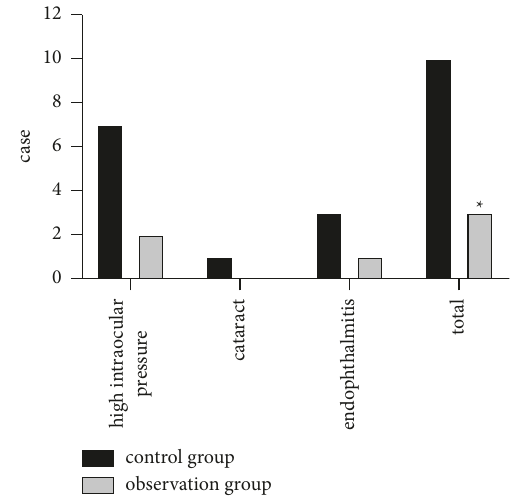
Figure 13: The occurrence of adverse reactions of the two groups of patients. Compared with the control group, ∗ P < 0 .